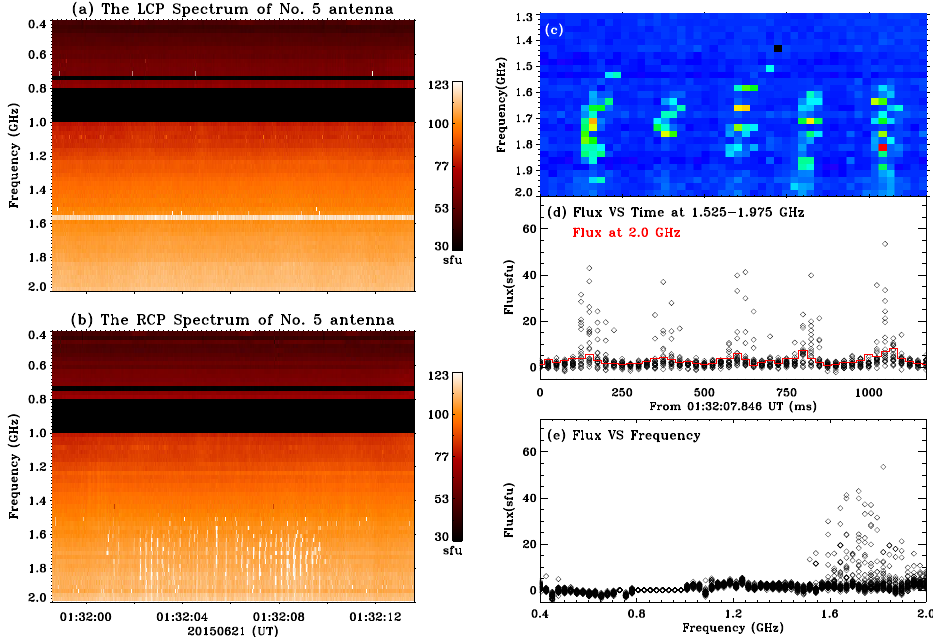
Figure 2. ( a , b ) The LCP and RCP spectrum from 01:31:58.597 UT to 01:32:13.597 UT observed by No.5 antenna of MUSER-I. ( c ) The zoomed-in spectral structure of QPSs from 01:32:07.846 UT. ( d ) The temporal evolution of the intensity of spikes by subtracting the continuum emission. ( e ) The frequency distribution of the intensity of spikes by subtracting the continuum